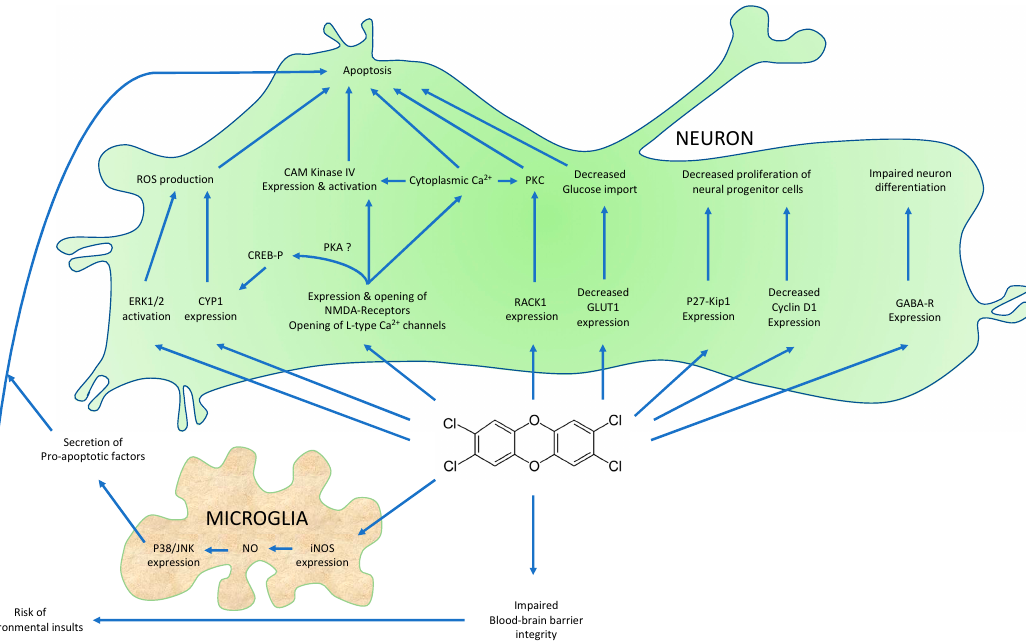
Figure 3. TCDD regulates neuronal cell proliferation, differentiation, and survival. ERK1/2: extracellular-regulated kinase 1/2; CYP1: cytochrome P450 1; CREB: cyclic adenosine monophosphate (cAMP)-responsive element binding protein; PKA: protein kinase A; NMDA: N -Methyl- D -Aspartate; RACK1: Receptor for activated C kinase 1; GLUT1: glucose transporter 1; GABA-R: gamma-aminobutyric acid receptor; iNOS: inducible NO synthase; NO: nitric oxide; JNK: jun-N terminal kinase.